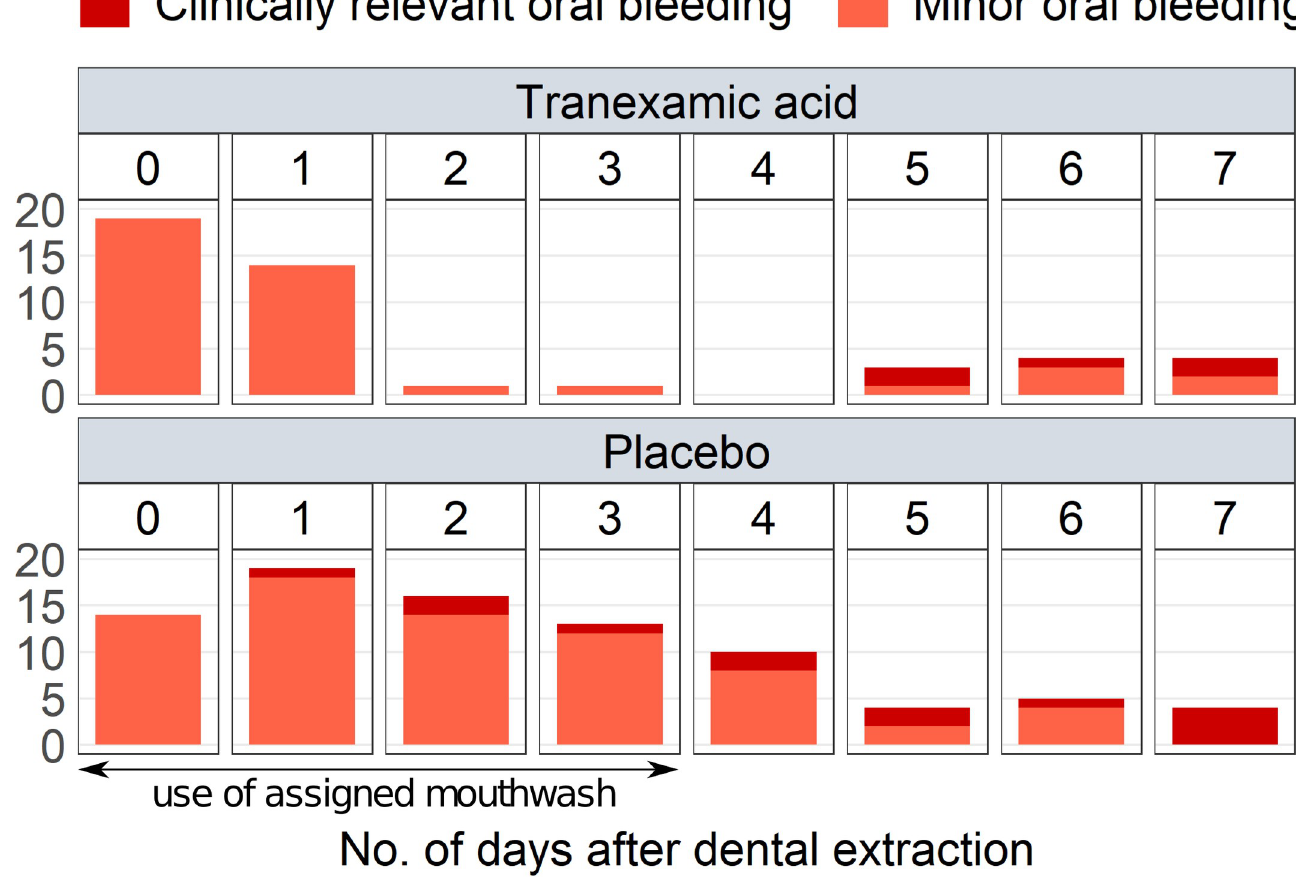
Fig 3. Clinically relevant and minor oral bleeds by day after dental